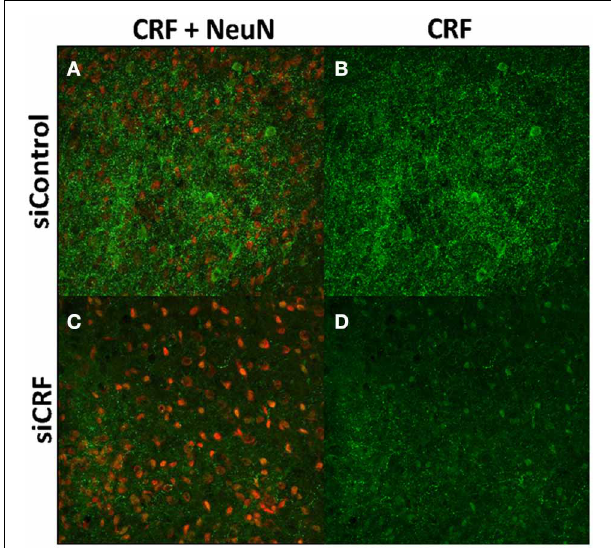
FIGURE 1 | Images (40X, Z-Scan) showing immunoreactivity for CRF (green) and NeuN (red) in the CeA of siControl injected (A,B) and siCRF injected CeA (C,D ; 1.5 µ l, 3.3 µ g, 48h post-injection). Immunoreactivity for CRF is robust in CeA of siControl injected while siCRF causes a substantial decrease in CRF signal with no effect on number of neurons.